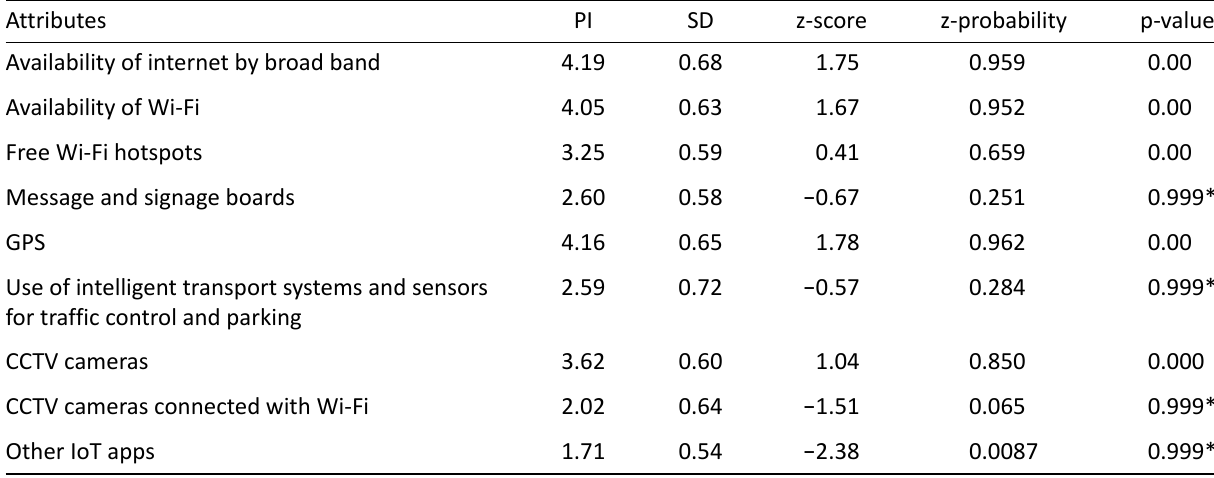
Table 2. Accessibility of ICT in the city